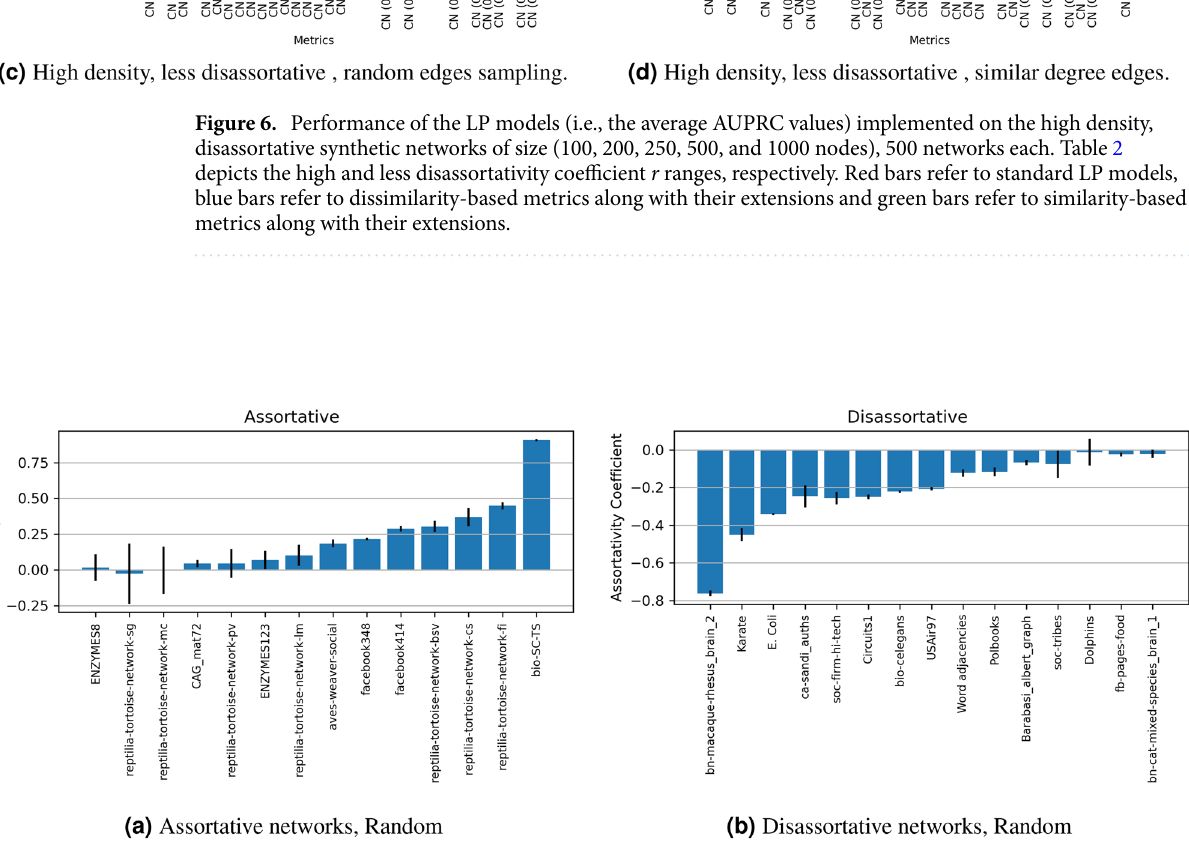
Figure 7. The average and standard deviation of the assortativity level of each of the standard networks after removing 20% of network edges at random for 30 separate runs. Edge removal of each run is implemented independently of other